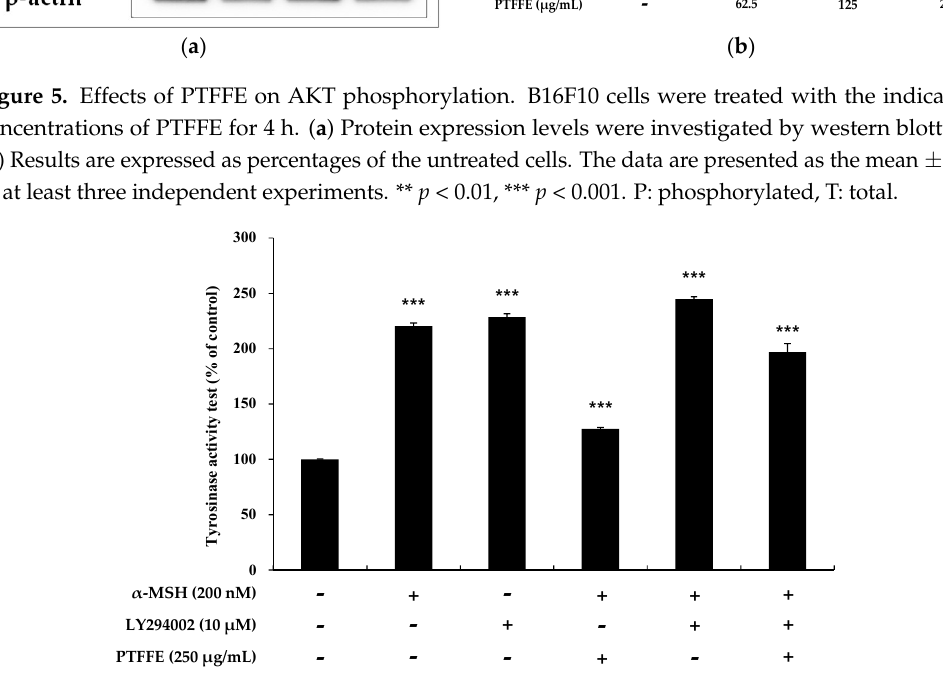
Figure 6. Effects of PTFFE and the AKT inhibitor LY294002 on tyrosinase activity in B16F10 cells. Cells were treated with α -MSH (200 nM) or LY294002 (10 µ M) alone or in combination and with or without PTFFE at the single concentration of 250 µ g/mL. Data are expressed as percentages of the untreated cells. The data are presented as the mean ± SD of at least three independent experiments. *** p < 0.001.